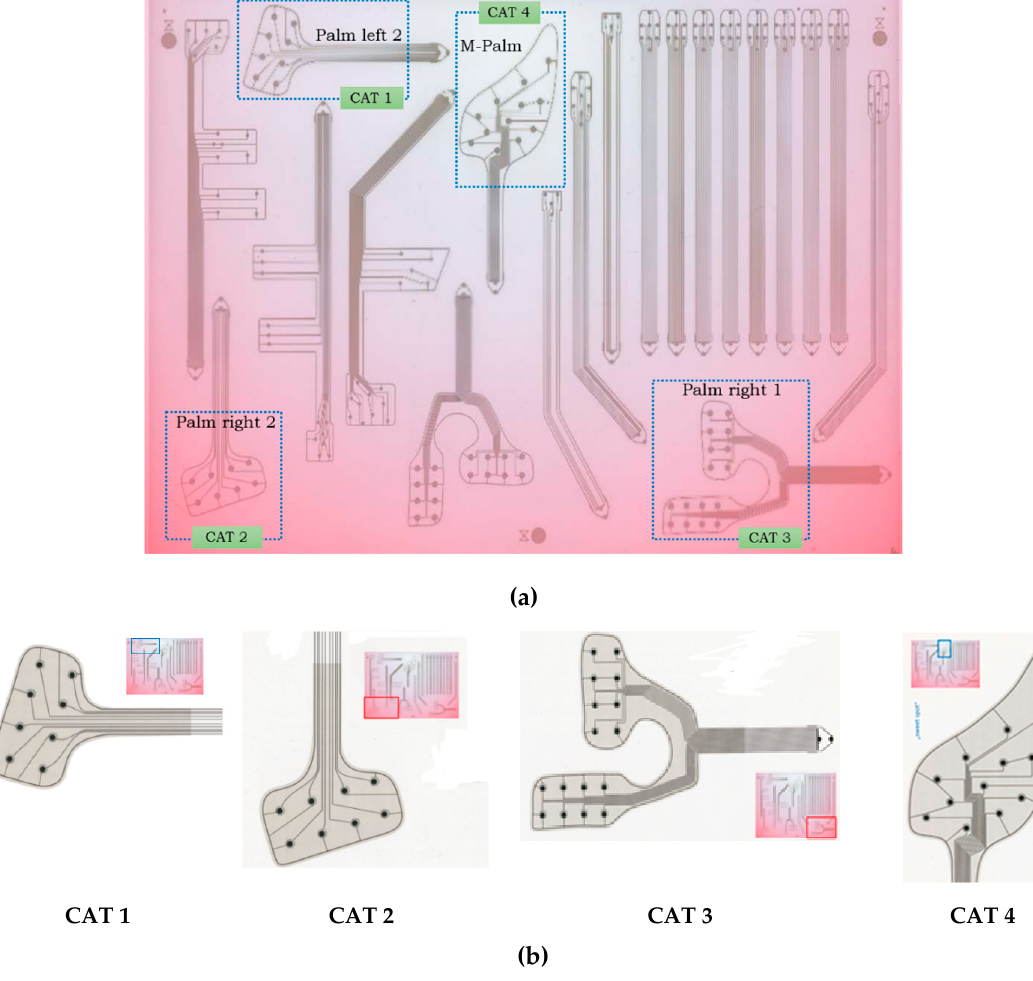
Figure 11. Compared categories (CAT1, CAT2, CAT3 and CAT 4) and heat map on the A3 fabrication substrate.( a ) Heat map of the fabrication and the selected categories for testing, ( b ) Zoom in view for each category’s location.